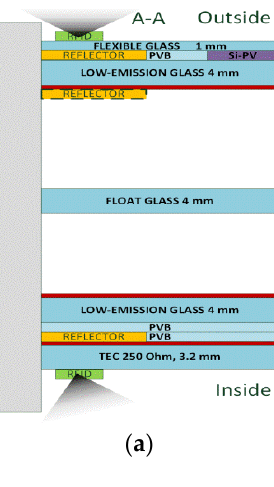
Figure 3. Localization of the RFID sensor in active glazing units: ( a ) implementation of RFID sensor with additional reflector; ( b ) structure of RFID sensor with additional reflector; ( c ) two-side communication after removing functional layer.